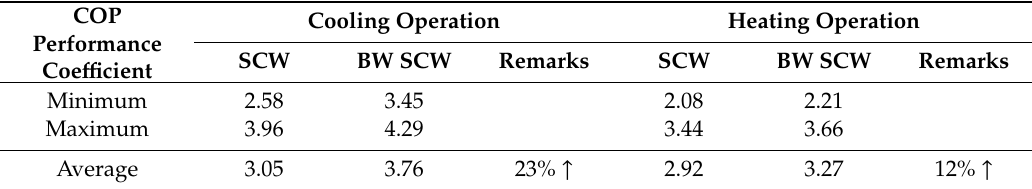
Table 8. Comparison of the performance factors of